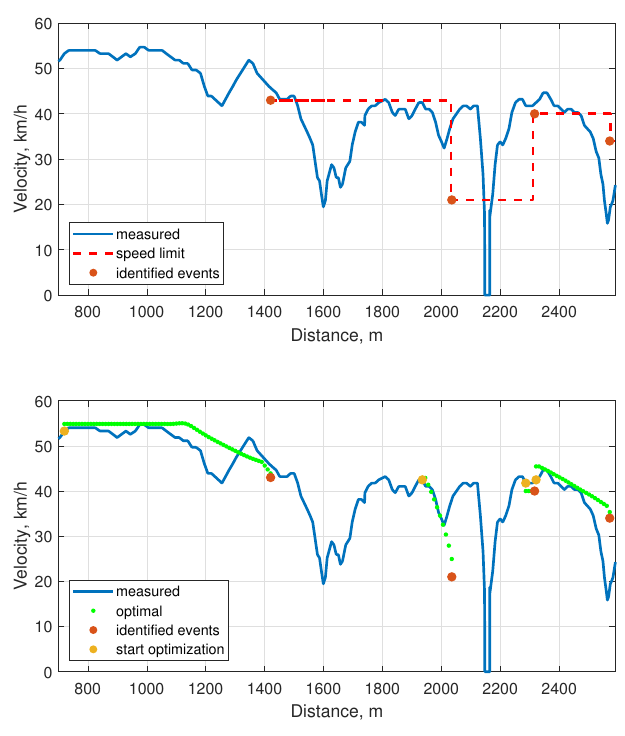
Figure 9. Top: the baseline velocity profile (blue line) and the speed limit (red dashed line). Bottom: the baseline velocity profile (blue line) compared to the optimized velocity (green dots). Orange dots: the eco-driving assistance system (EDAS) has detected a speed limit event and started optimization. Red dots: speed limiting